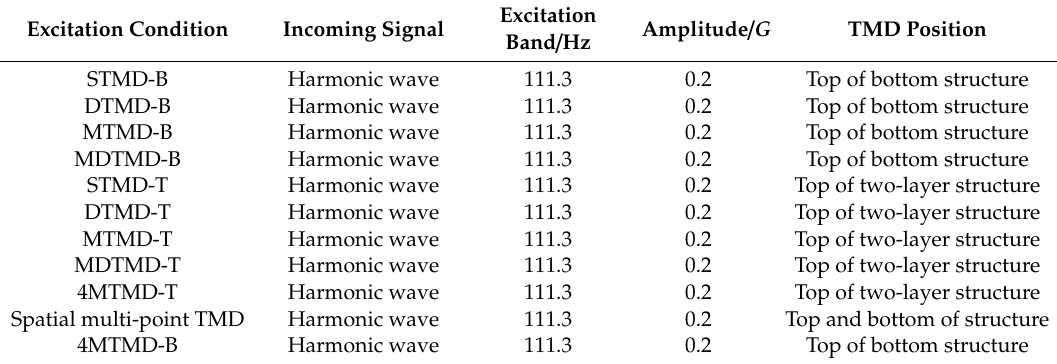
Figure 4. Forms of TMDs in the structure: ( a ) single-tuned mass damper (STMD)-B; ( b ) dual-tuned mass damper (DTMD)-B; ( c ) multiple-tuned mass damper (MTMD)-B; ( d ) multiple dual-tuned mass damper (MDTMD)-B; ( e ) STMD-T; ( f ) DTMD-T; ( g ) MTMD-T; ( h ) MDTMD-T; ( i ) quadruple TMD-T; ( j ) spatial multi-point TMD; and ( k ) quadruple TMD-B. Table 2. Vibration reduction test